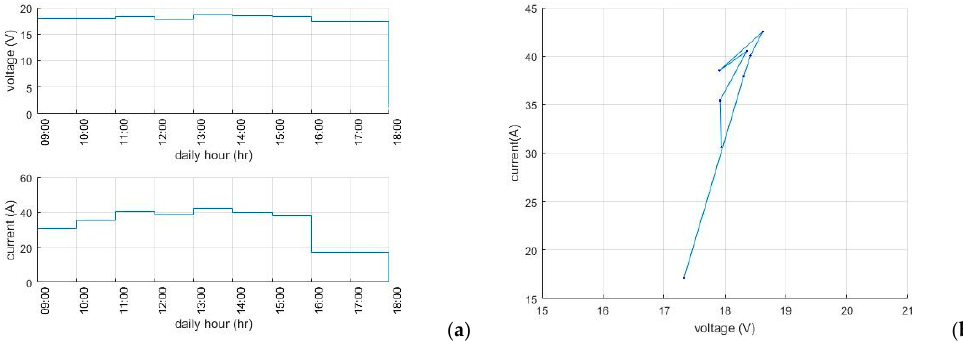
Figure 6. Current and voltage profile of PV modules: ( a ) current and voltage per hour and ( b ) current versus voltage.